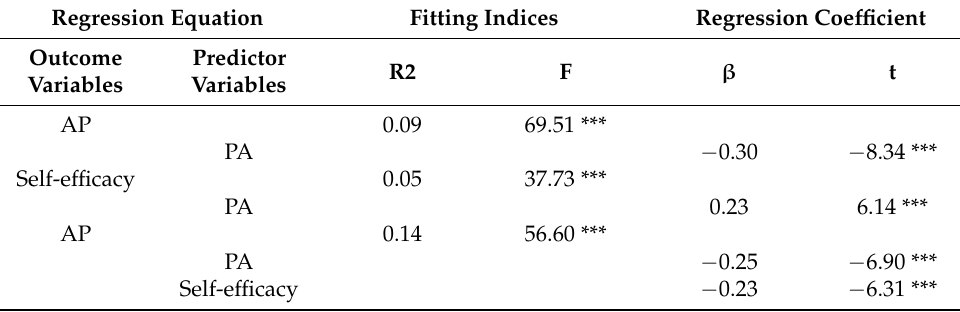
Table 4. Mediation analysis results for the three